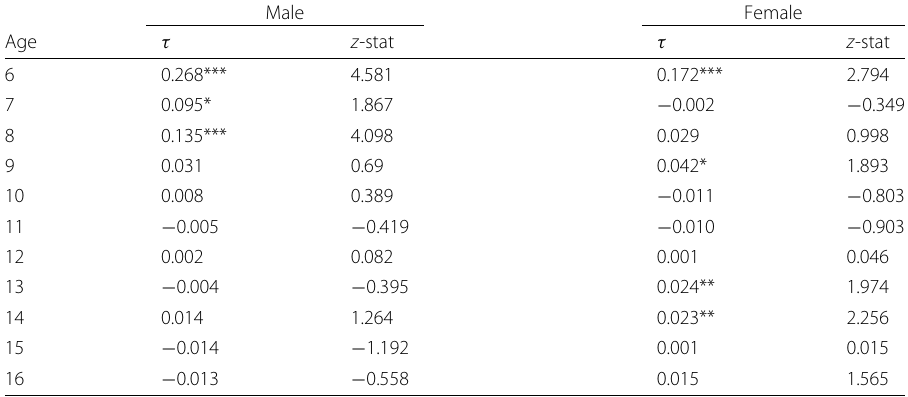
Table 3 RD estimates of the grade gap by